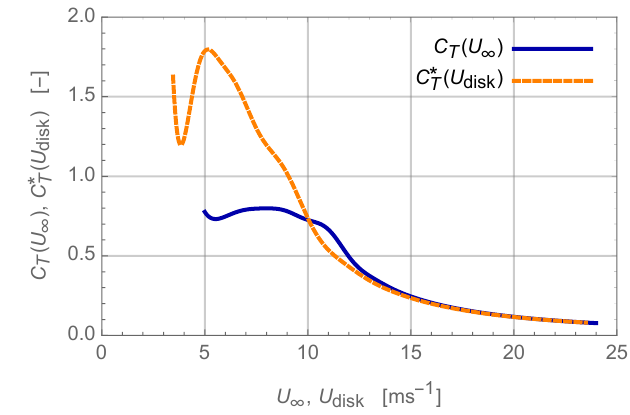
Figure 2. Thrust coefficient C T and modified thrust coefficient C ∗ as functions of U ∞ and U disk ,